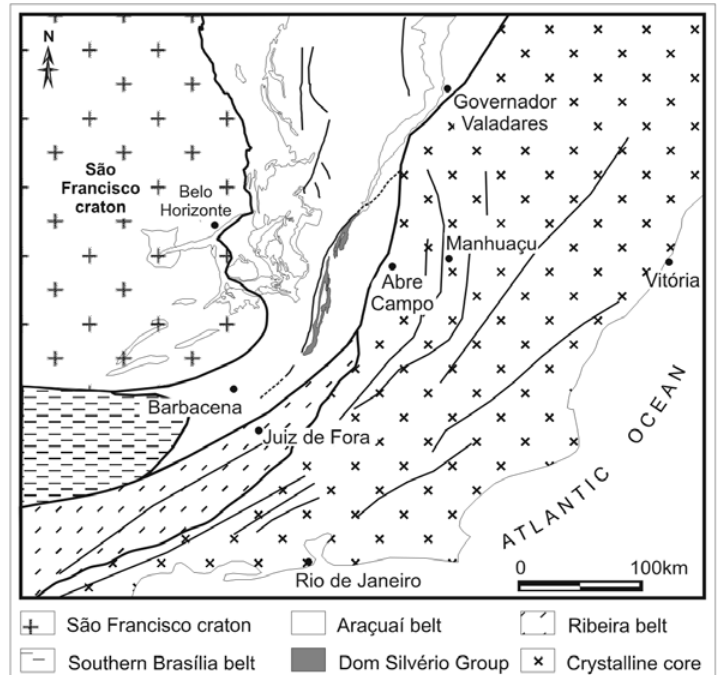
Fig. 2 – Simplified geologic map showing the location of the Araçuaí, Ribeira and Brasília belts and the crystalline core of the southern Araçuaí-West Congo orogen. Modified from Brueckner et al.